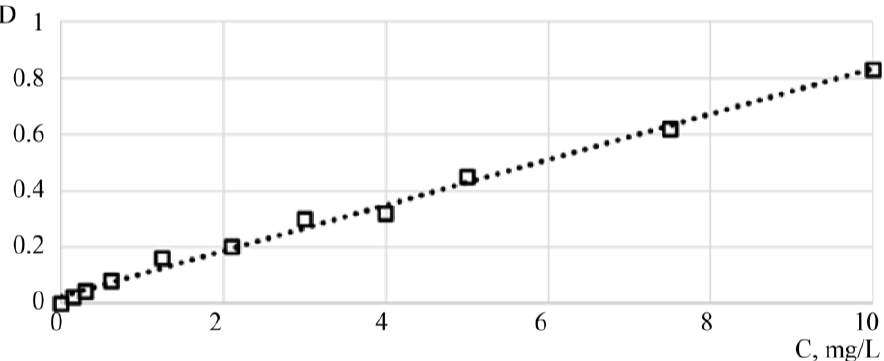
Figure 1. Calibration graph for determining the concentration of copper cations.